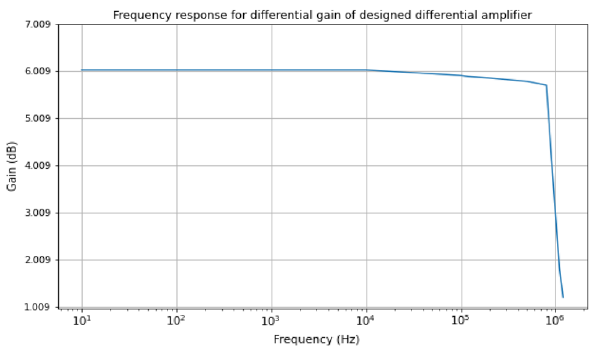
Fig. 13 Frequency response of proposed differential amplifier showing distinct − 3 dB response at 1 MHz